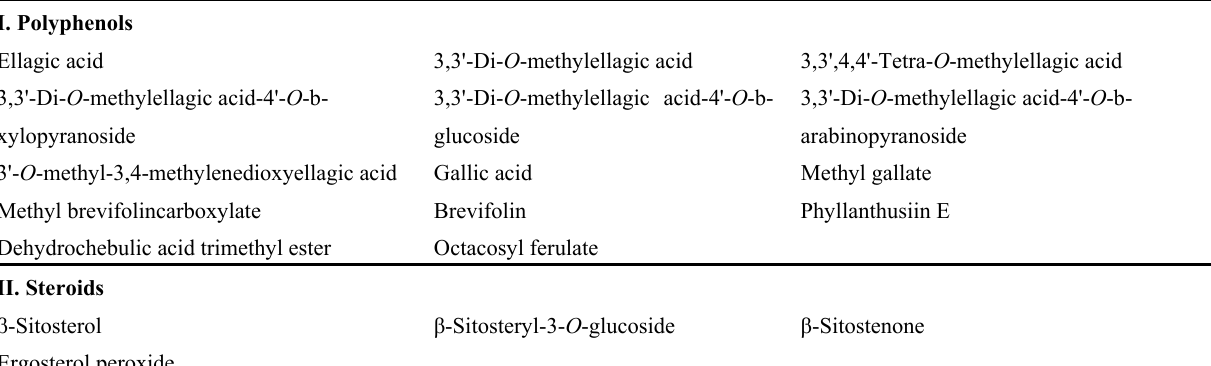
Table 1. Compounds purified from Euphorbia formosana